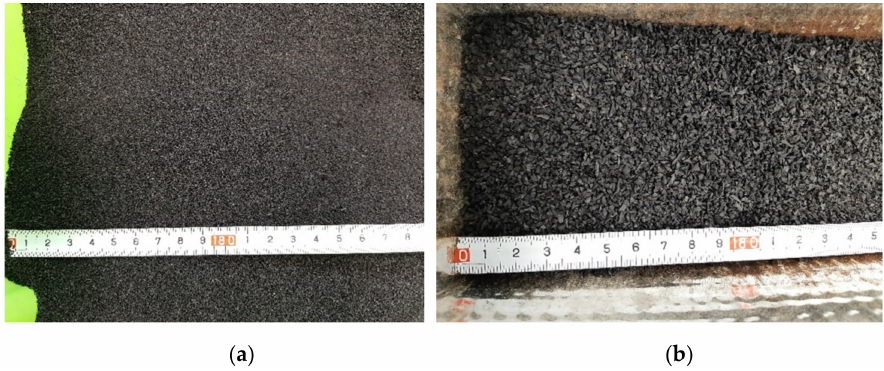
Figure 3. Rubber waste: ( a ) powder 0.5–1.0 mm; ( b ) granulate 1.0–2.0